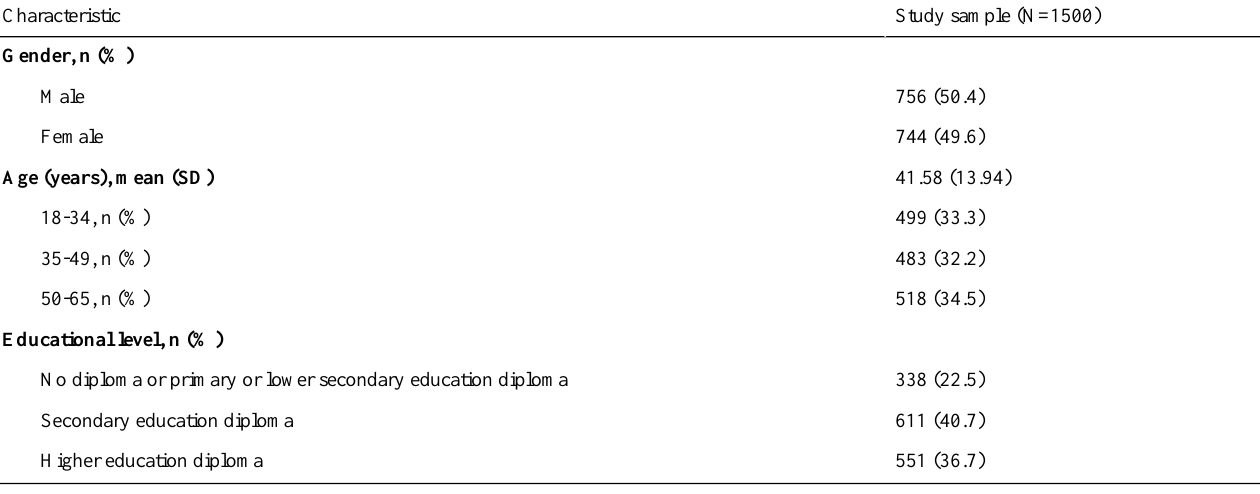
Table 3. Characteristics of the study